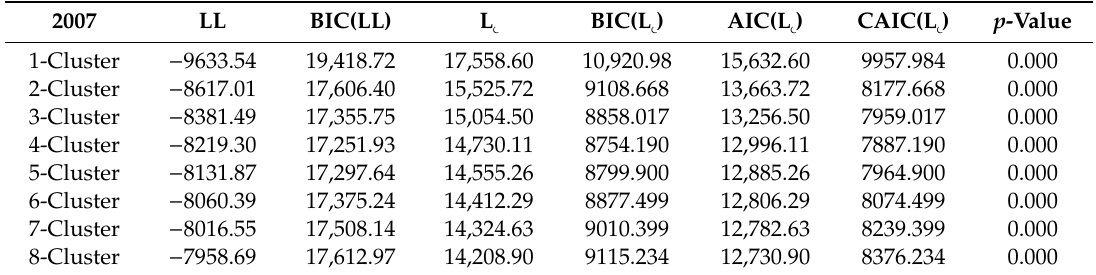
Table 1. Results of the Test for the Estimated Cluster Models in 2007.